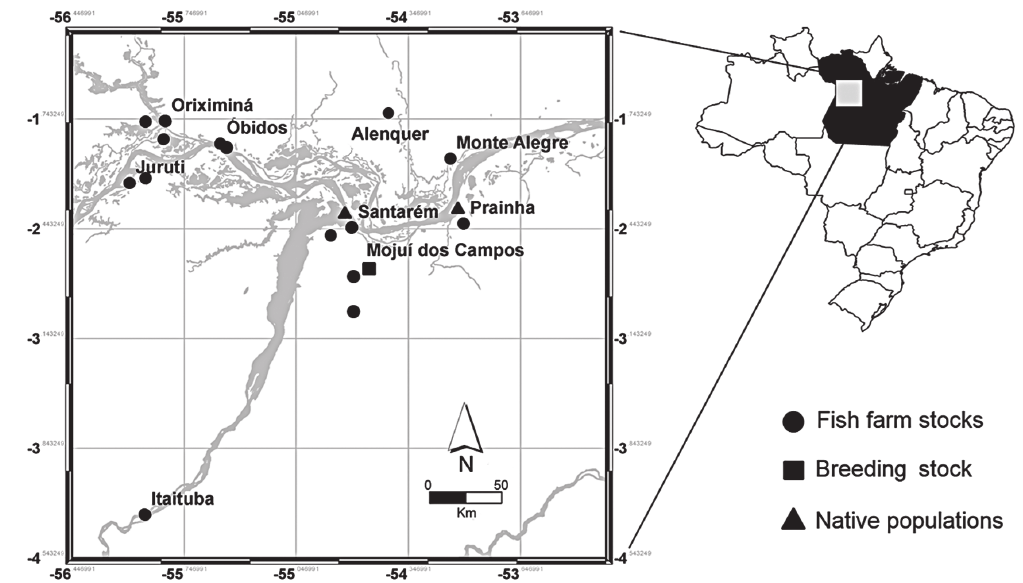
Figure 1 - Map of the sites at which samples were collected in the western extreme of the Brazilian state of